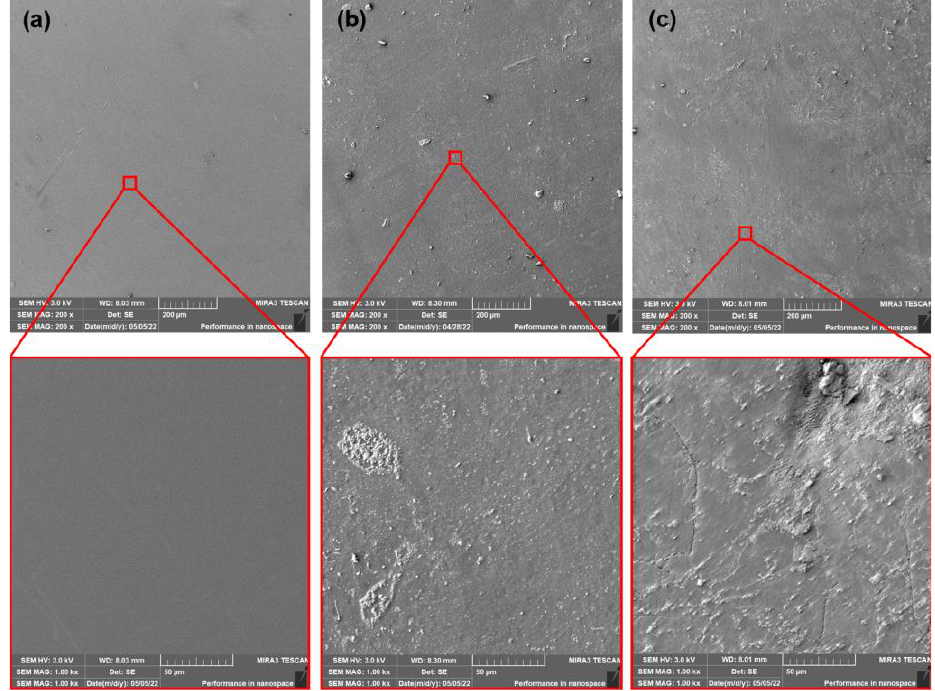
Figure 6. SEM images of as-produced neat PLA films ( a ) at initial state and after ( b ) 14 days of thermophilic composting, and ( c ) 28 days of thermophilic composting.